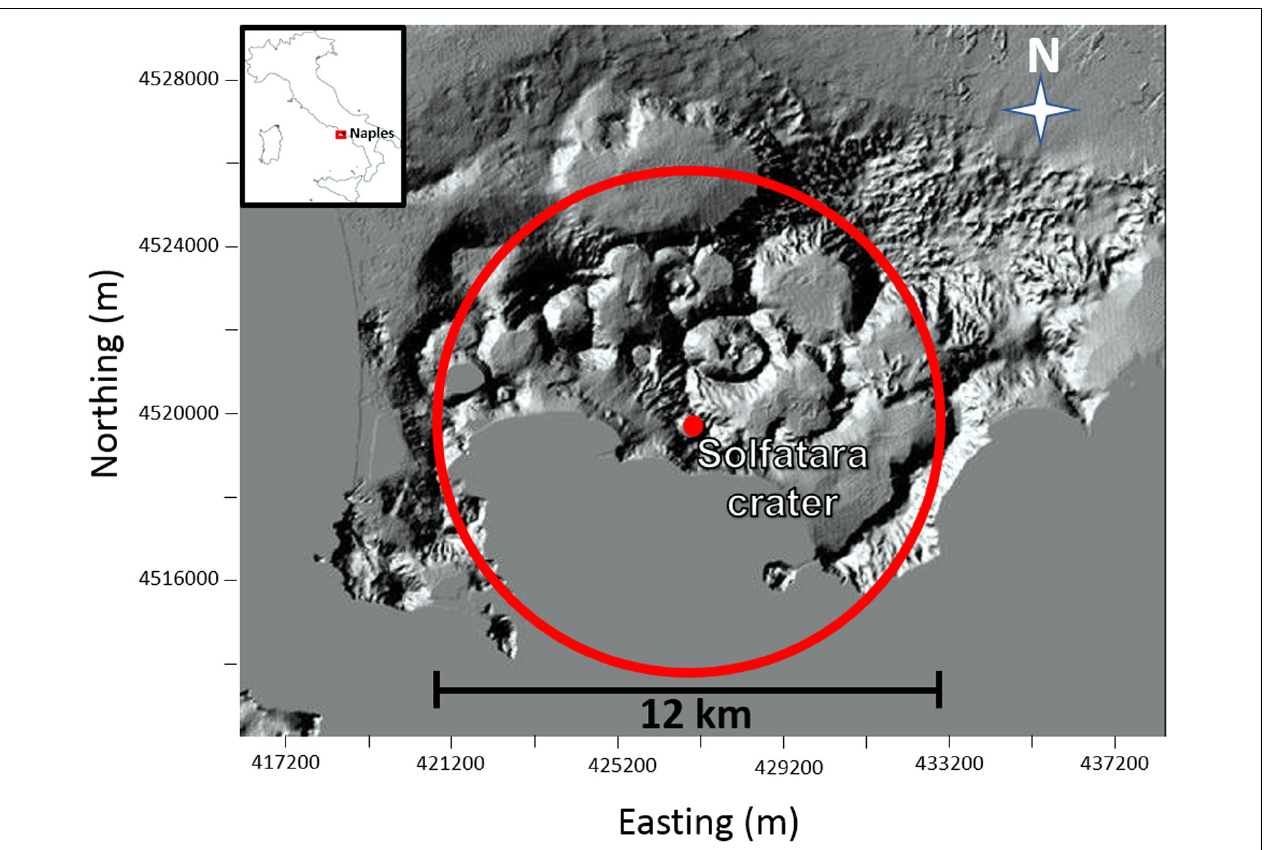
FIGURE 2 | Campi Flegrei volcanic area (Southern Italy). The red circle shows the diameter of the petrophysical model used to simulate the dynamics of the CF hydrothermal system. The red point indicates the center of the model that is located at the Solfatara